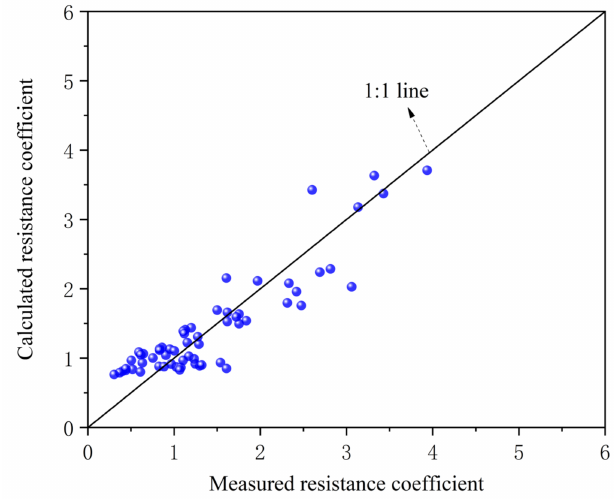
Figure 13. Comparison between the calculated and measured resistance coefficients. Table 4. Calculation results of different statistical